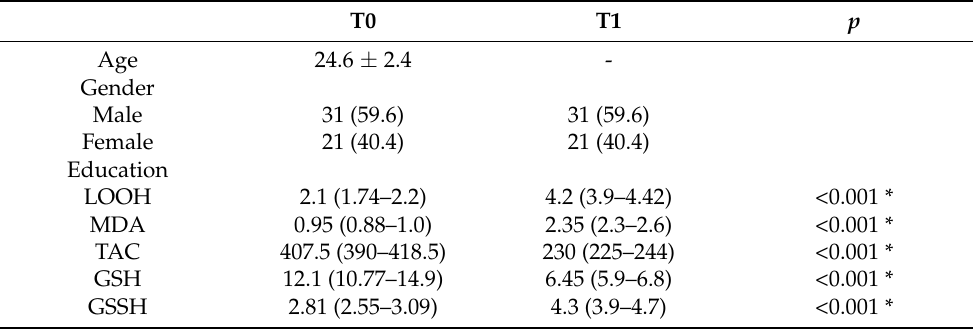
Table 1. Socio-demographic and clinical characteristics of sample (% frequency).